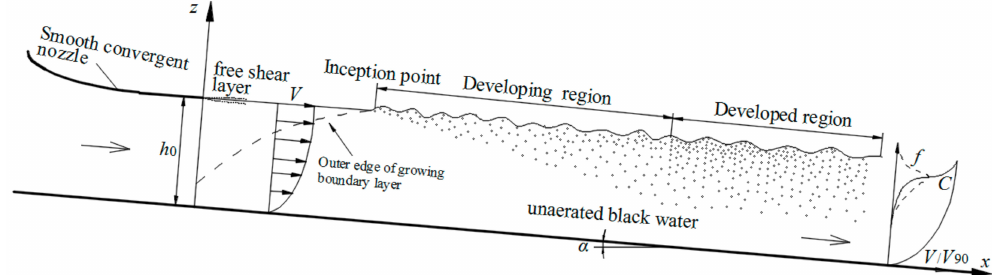
Figure 1. Sketch of self-aeration in the open channel